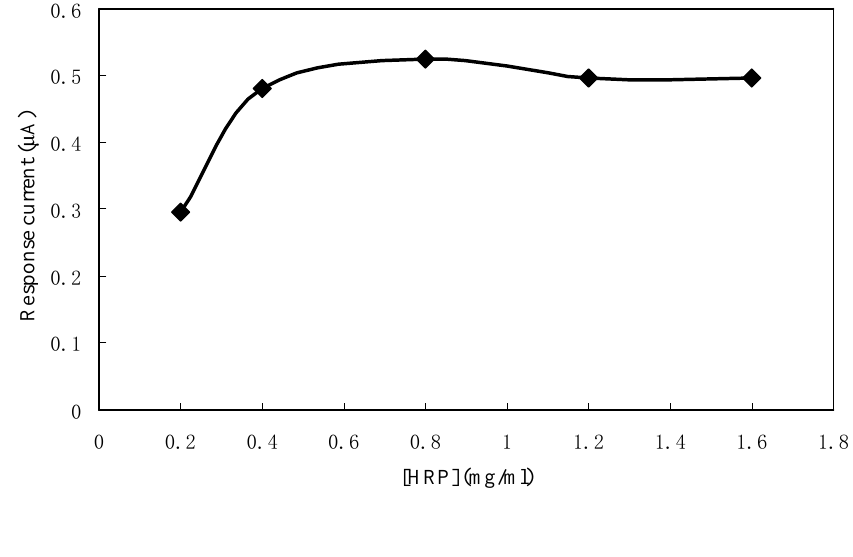
Figure 5. Effect of HRP concentration on response current to 1 mM H O (1 µ L, -300 mV potential 2 2